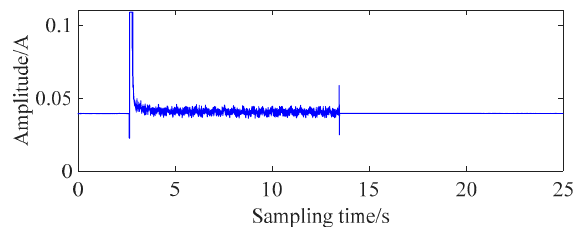
Figure 7. Signal of gear-scuffing fault.